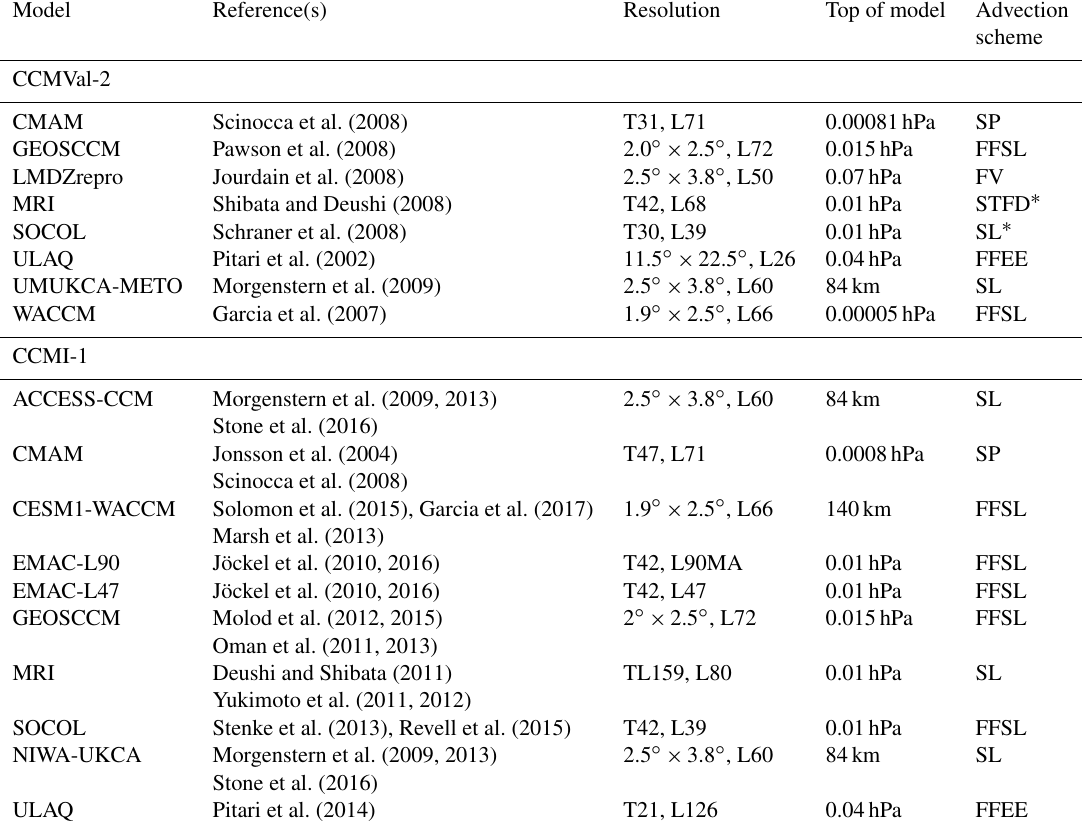
Table 1. Overview of the CCMs and their simulation setups used in the present study. The reference(s), the horizontal and vertical resolution (number of model layers), and the model top and the advection schemes (of chemical tracers) of the individual models of CCMVal-2 (upper rows) and CCMI-1 (lower rows) are listed. For the spectral models, horizontal resolution is given as triangular truncation of